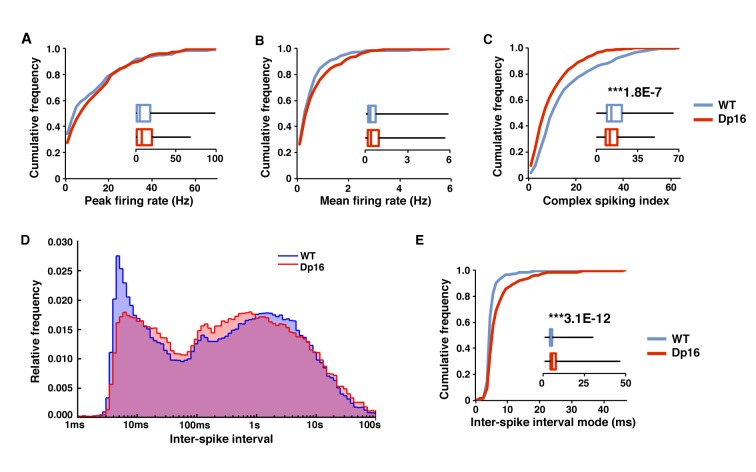
Decreased bursting of CA1 pyramidal cells in Dp(16)1Yey mice during post-exploratory rest.During post-exploratory quiescent periods the peak firing rate (A) and mean firing rate (B) were not significantly different between the WT and Dp(16)1Yey groups. (C) The complex spiking index was significantly decreased in Dp(16)1Yey CA1 pyramidal cells. (D) The ISI distribution shows two populations of events in CA1 pyramidal cells from WT mice. The peak of events with an ISI between 2 and 15 ms correspond to spikes included in complex bursts. The second large population of events with higher ISI represents single isolated spikes. In the Dp(16)1Yey the peak of short ISI events was smaller than in WT, whereas the population of isolated single spikes tended to be larger. (E) The inter-spike interval (ISI) mode, defined as the most probable inter-spike interval for each recorded neuron, was significantly longer in the Dp(16)1Yey group than in their WT littermates. Statistical significance was assessed using Mann-Whitney U-test with significance set at (***) p<0.001.10.7554/eLife.31543.008Figure 3—source data 1.Pyramidal cells characteristics during awake-rest - full data set.